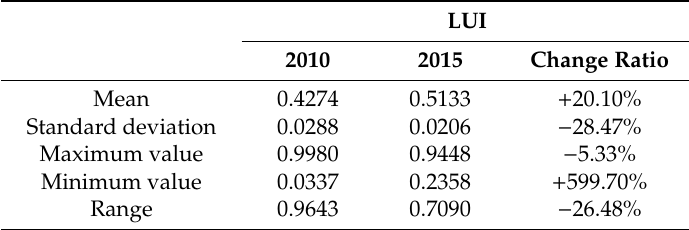
Table 2. The descriptive statistics of land use intensity in the BTH urban